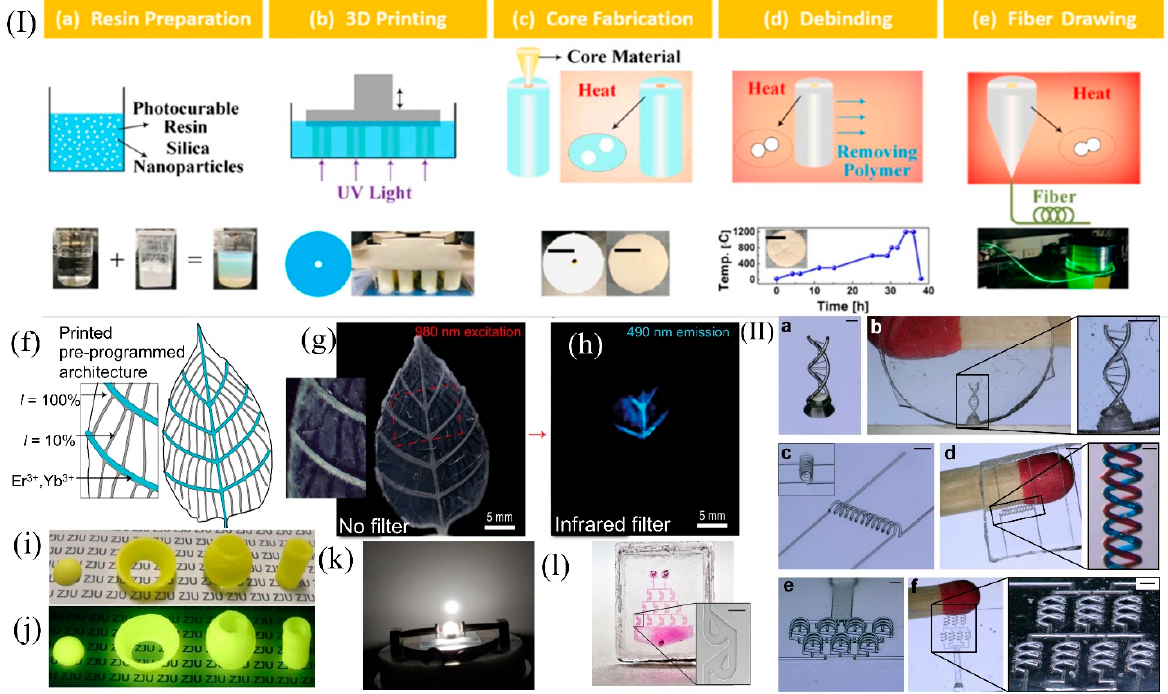
Figure 4. ( I ) ( a – e ) Fabrication process of the step-index silica optical fiber using 3D printing. The patterns of primary and secondary veins are shown in ( f , g ). The area covered with doped glass under infrared light radiation shows intense blue light, as shown in ( h ). ( i ) Examples of printed and sintered YAG:Ce-PiSG (scale bar, 1 cm) and ( j ) the same objects under UV radiation [16]. ( k ) Lighted WLED device in the darkness [16]. ( l ) Microlithography of an exemplary microfluidic chip (inset scale bar, 200 μ m) ( II ). ( a ) Polymeric DNA double helix (scale: 500 μ m). ( b ) Inverse structure in fused silica glass (scale: 400 μ m). ( c ) Intertwined spirals (scale: 900 μ m). ( d ) Resulting intertwined microfluidic spiral channels in fused silica glass with a channel width of 74 μ m. The channels were filled with dyes (see inset, scale: 140 μ m). ( e ) Polymeric microstructures of an out-of-plane mixer structure (scale: 600 μ m). ( f ) Microfluidic mixer structure in fused silica glass with a channel width of 74 μ m (scale bar: 280 μ m) [81]. ( I ) ( a – e ) Reprinted with permission from ref. [34] © The Optical Society. ( f – h ) Reprinted with permission from ref. [80]. ( l ) Reprinted with permission from ref. [35].